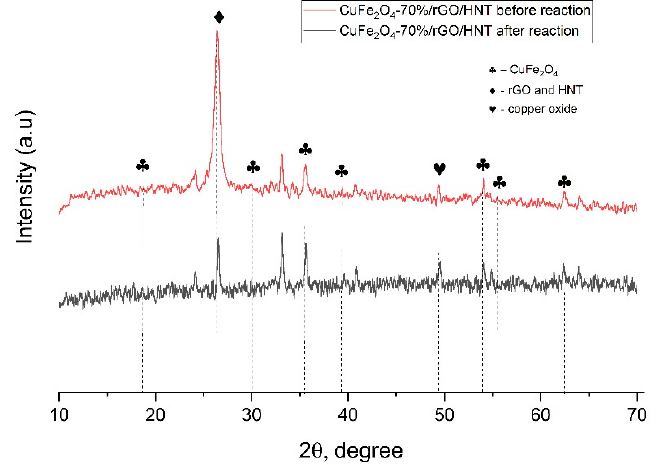
Figure 16. XRD spectra of CuFe 2 O 4 -70%/rGO/HNT before and after five cycles of regeneration.